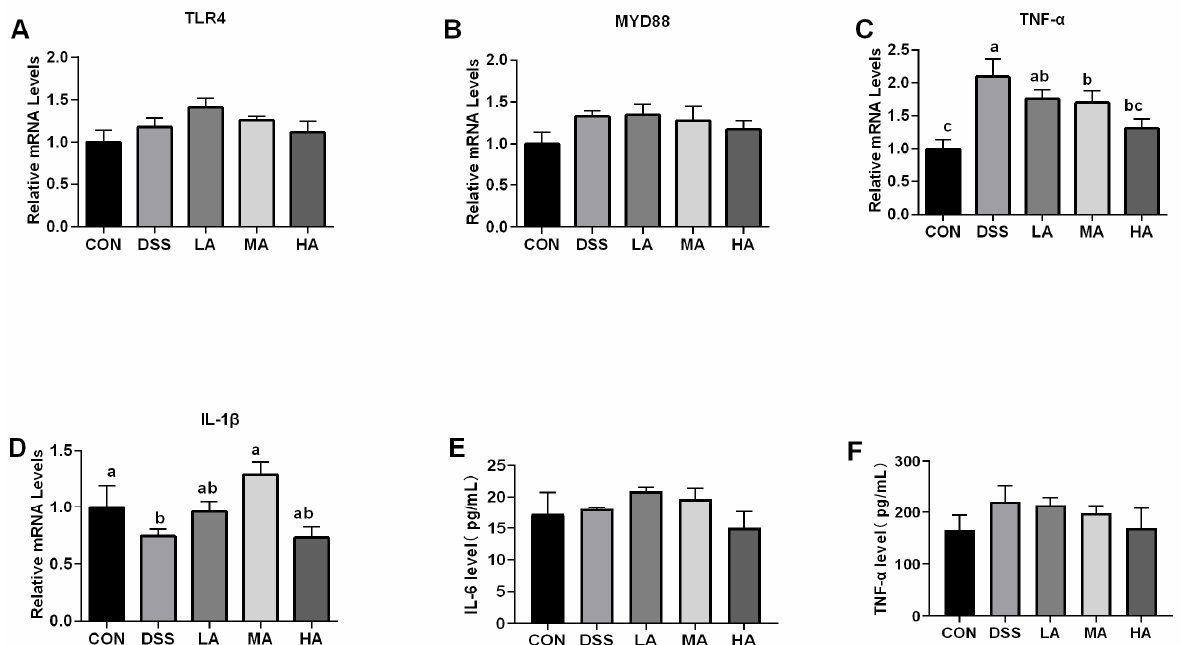
Figure 2. The effects of aspartate on the concentration of inflammatory cytokines and the expression of inflammation related-genes in the colon of the DSS-induced mice. ( A ) The mRNA expression level of colonic TIR4. ( B ) The mRNA expression level of colonic MYD88. ( C ) The mRNA expression level of colonic TNF- α . ( D ) The mRNA expression level of colonic IL-1 β . ( E ) The content of IL-6. ( F ) The content of TNF- α . Values are expressed as mean ± SEM, n = 6. a, b, c Mean values with different small letter superscripts mean a significant difference ( p < 0.05).